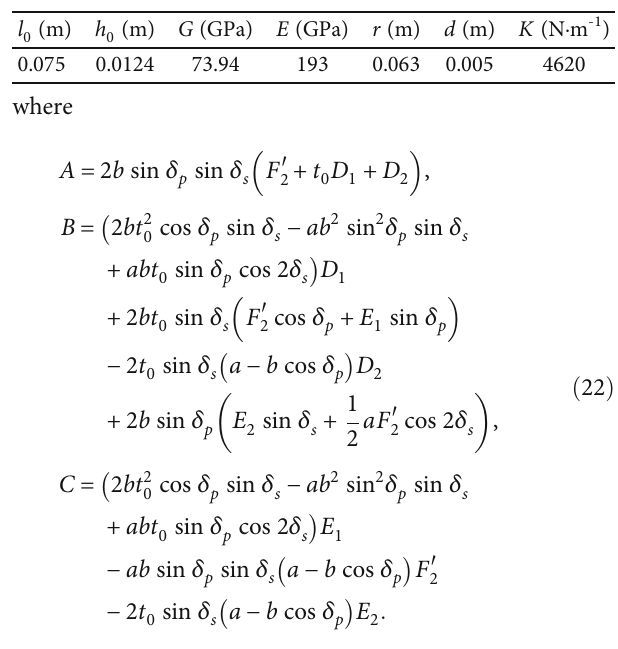
Table 1: Parameters of compression coil